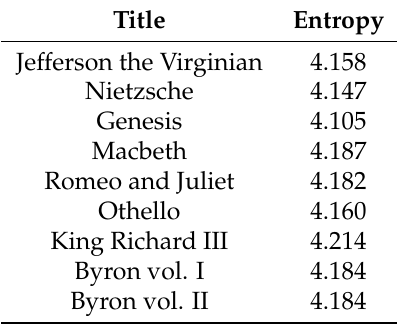
Table 2. Entropy of English writings.